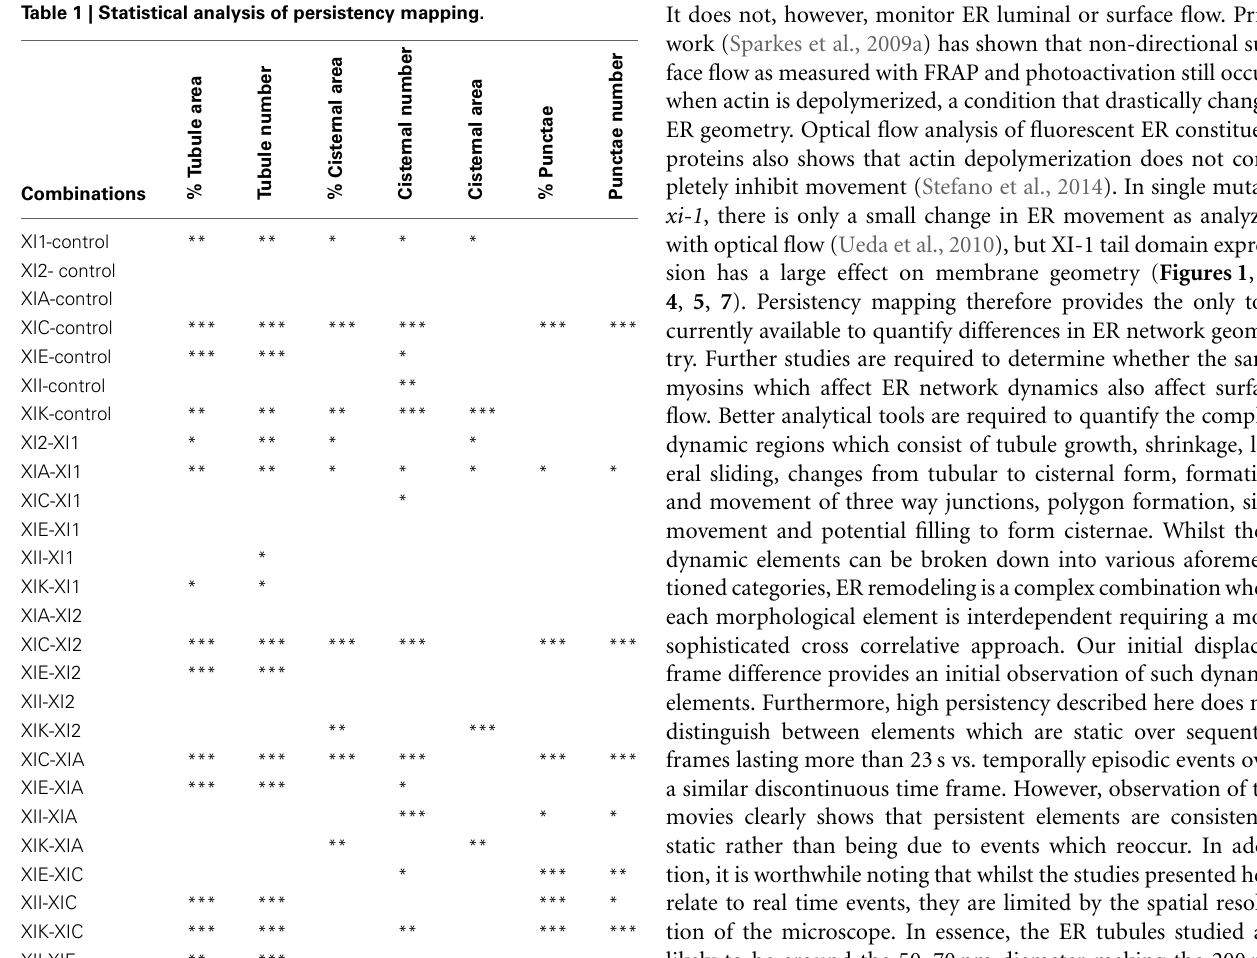
Table 1 | Statistical analysis of persistency